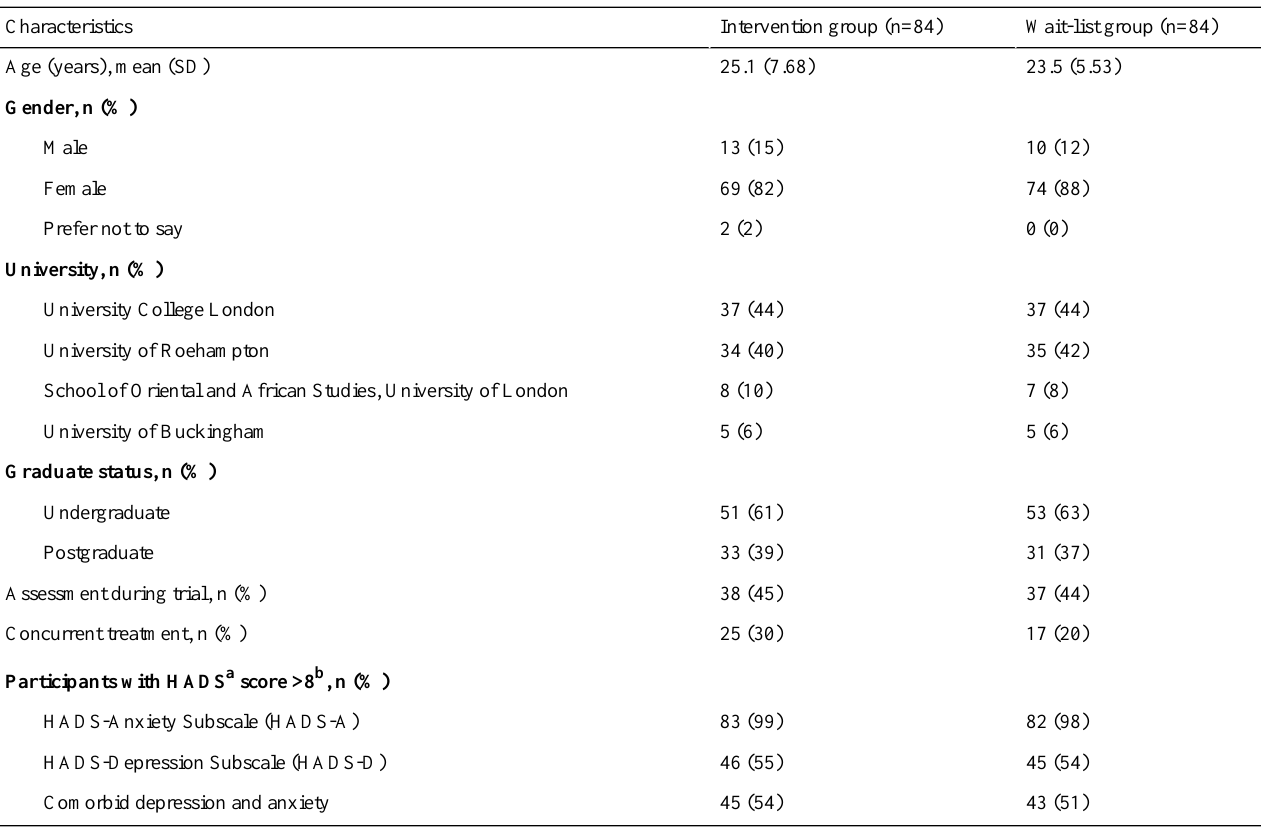
Table 1. Baseline demographic and clinical characteristics by study